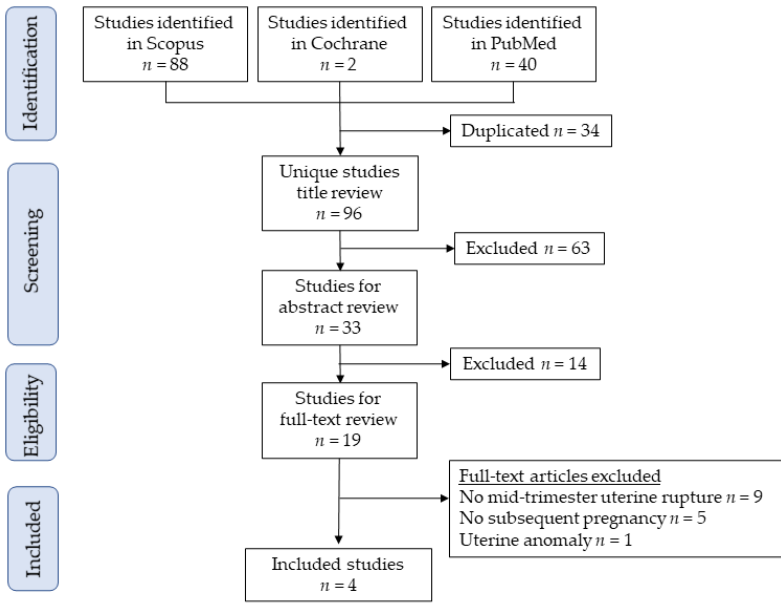
Figure 3. Study selection scheme used for the systematic review of the literature.